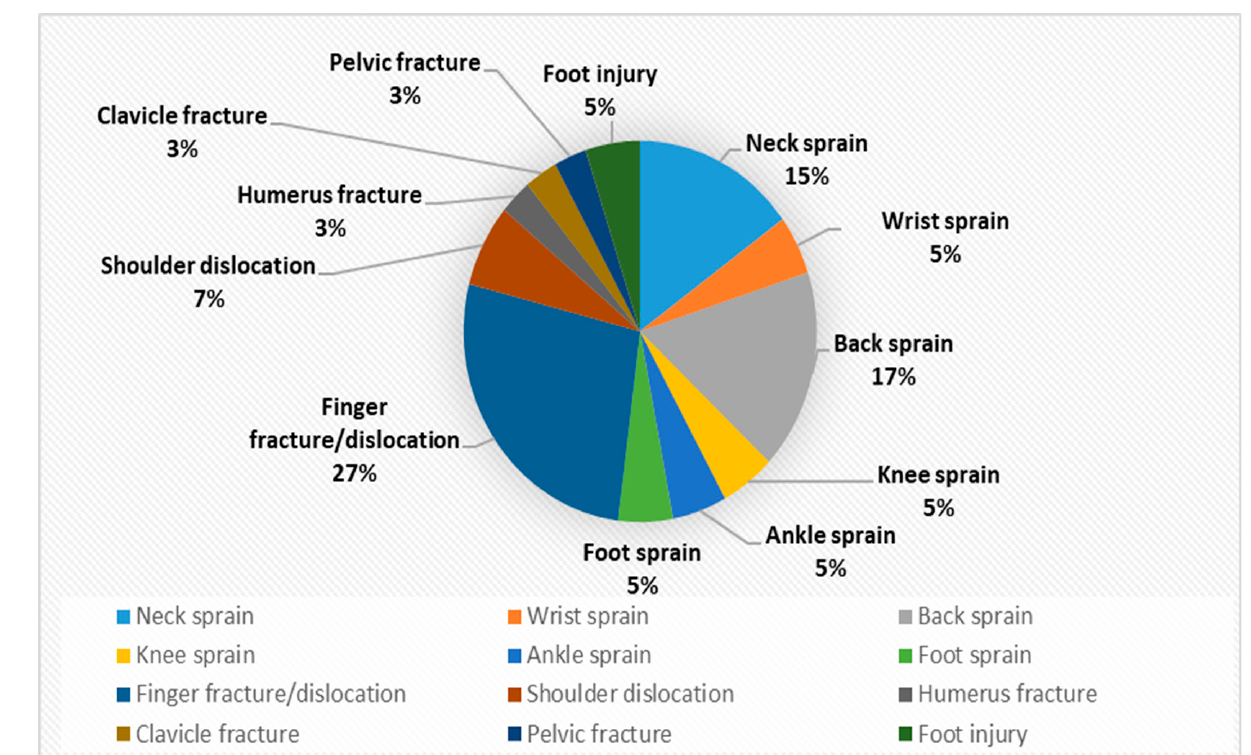
Figure 2. Composition of head and neck injuries as a % ( n = 58).